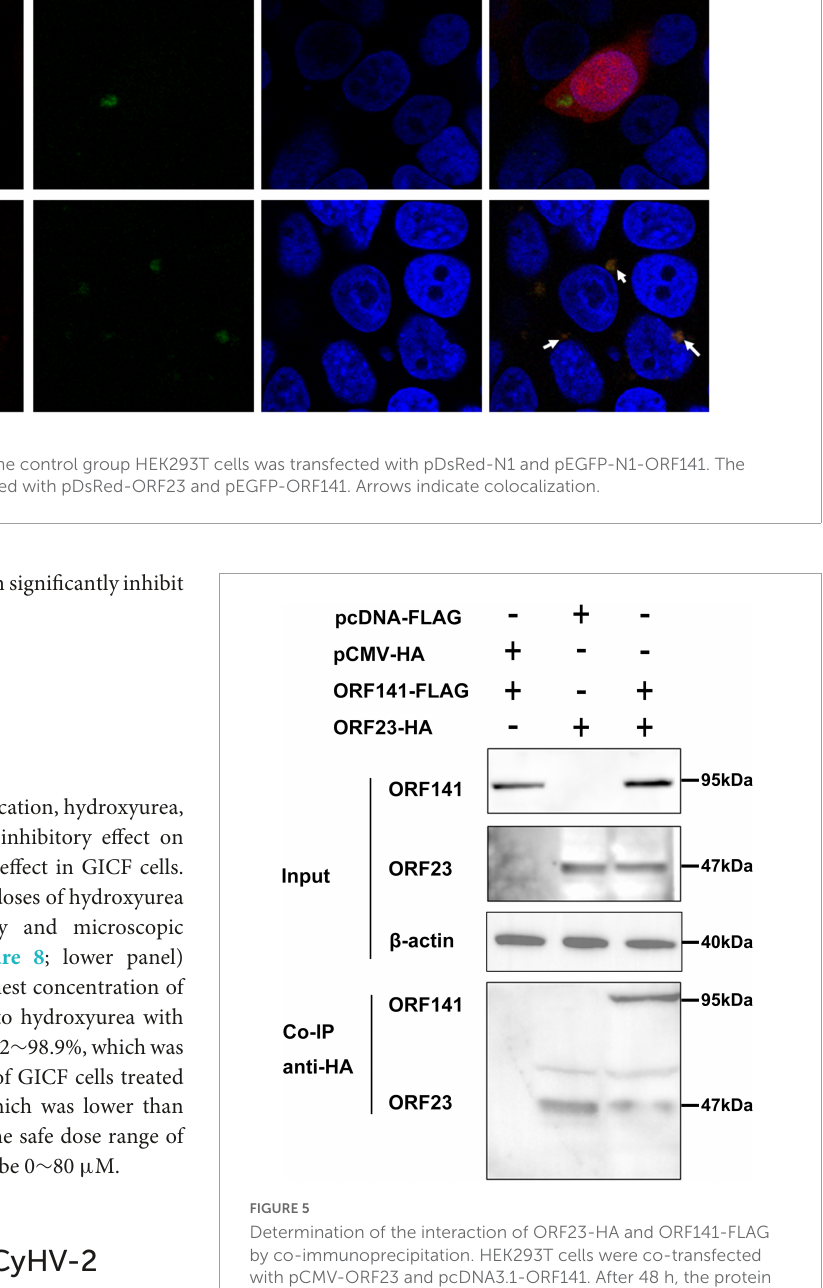
FIGURE5 Determination of the interaction of ORF23-HA and ORF141-FLAG by co-immunoprecipitation. HEK293T cells were co-transfected with pCMV-ORF23 and pcDNA3.1-ORF141. After 48 h, the protein was extracted and co-immunoprecipitated using HA-tagged antibody. Subsequently, Western blot analysis was performed by elution. The β - actin was used as a loading